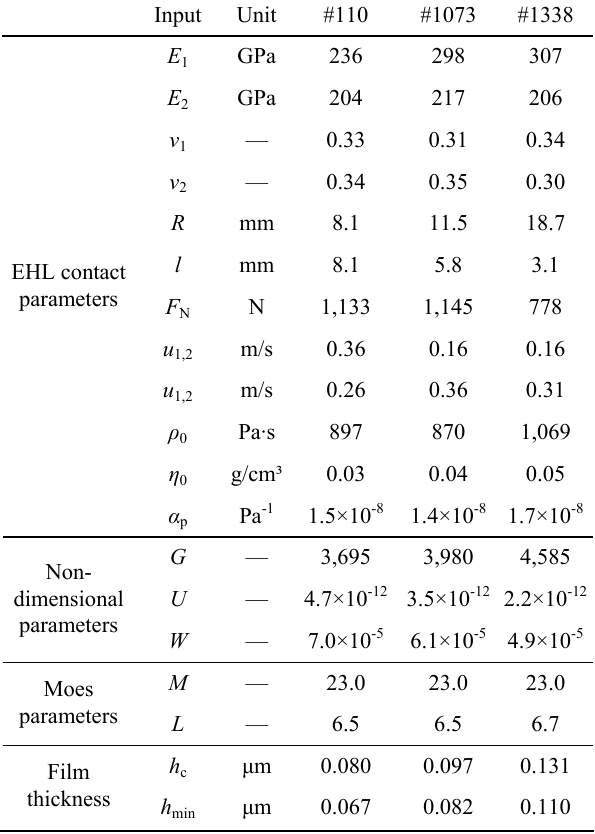
Table 6 Exemplary points from the data base for the infinite 2D line contact with inconsistency in the film thickness when using the non-dimensional parameters G , U , W , or M , L instead of the original input